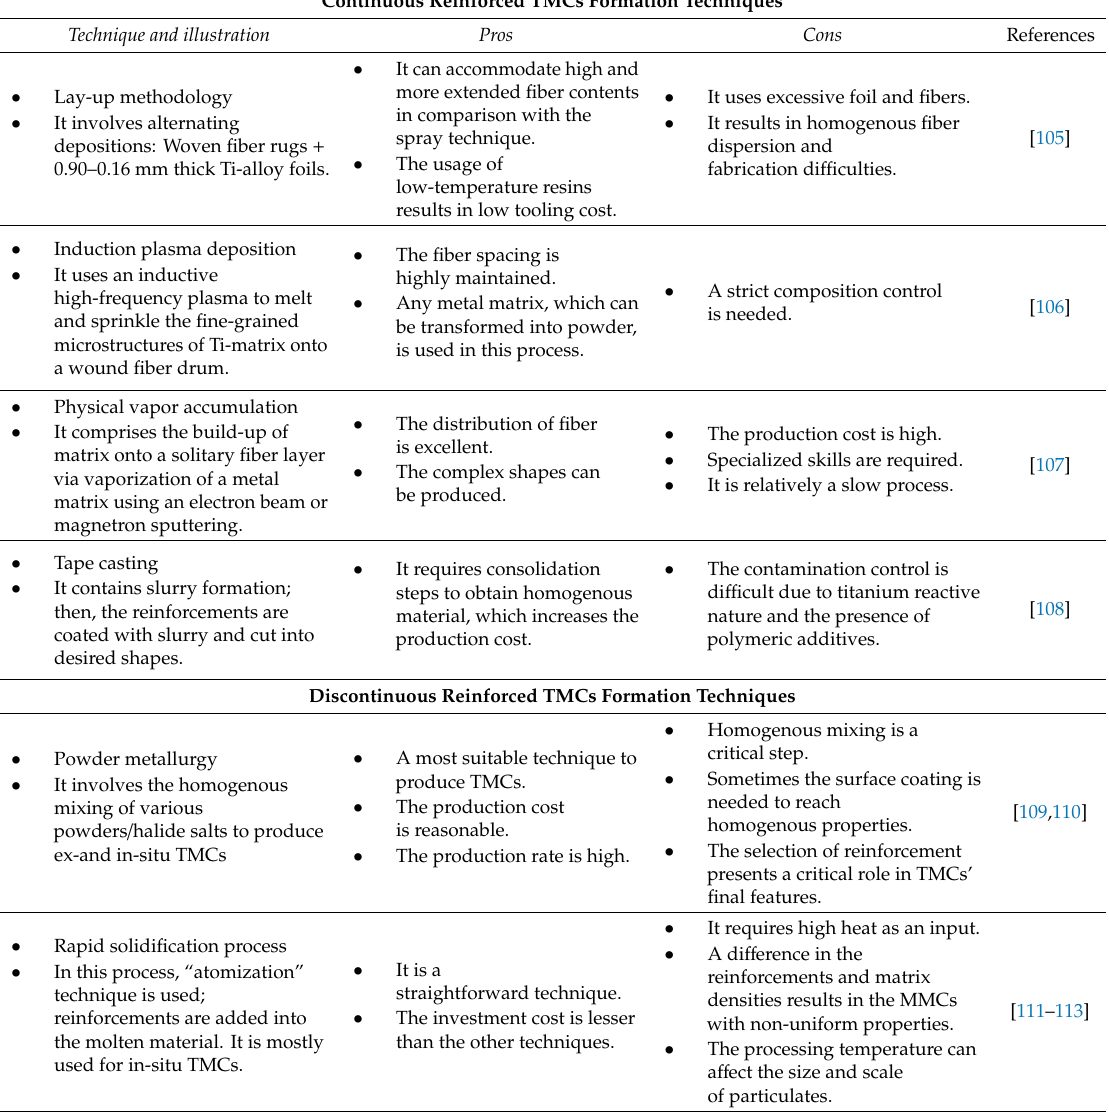
Table 6. Continuous and discontinuous TMCs formation